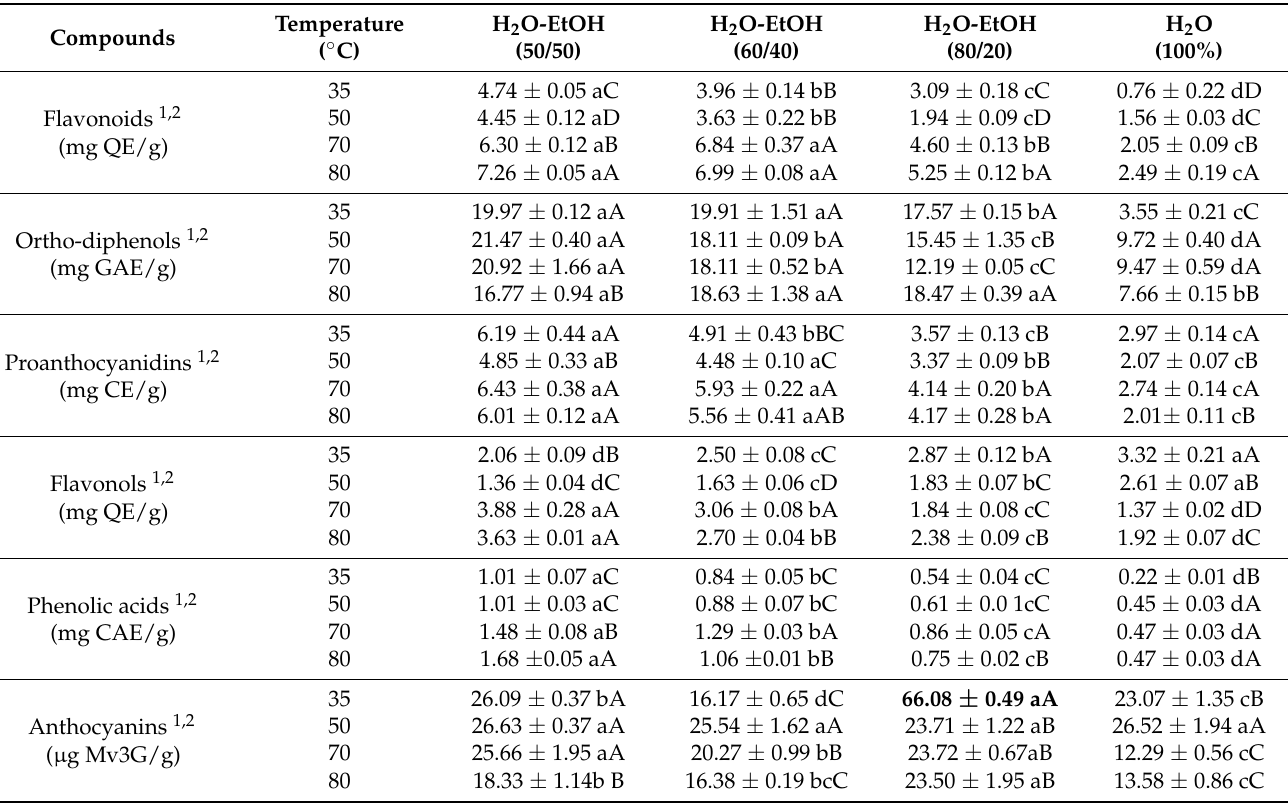
Table 1. Content of different families of phenolic compounds in the extracts according to the type of solvent and extraction